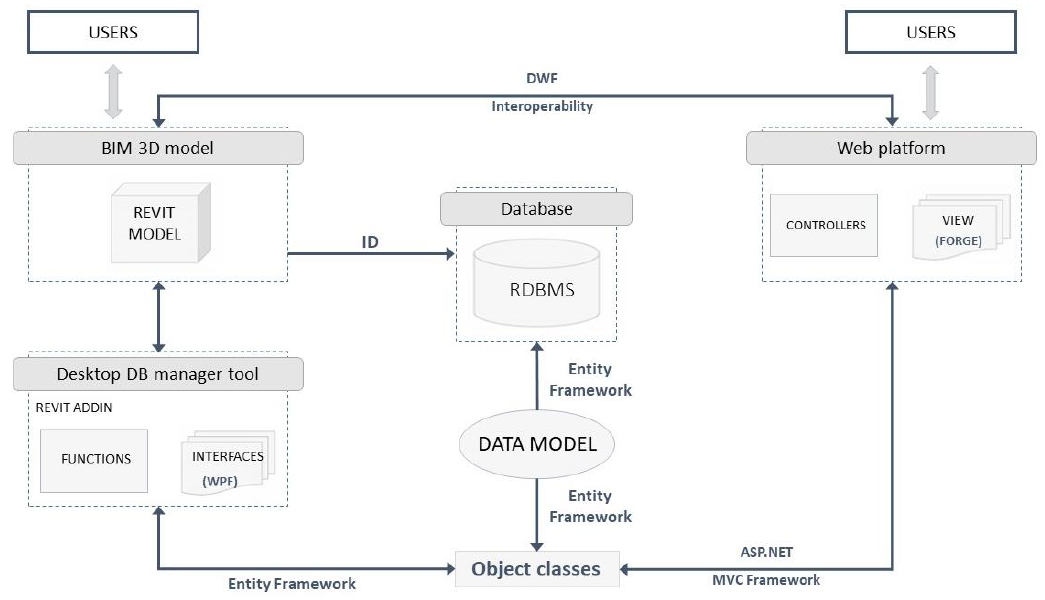
Figure 1. Schema of the implemented system’s architecture.